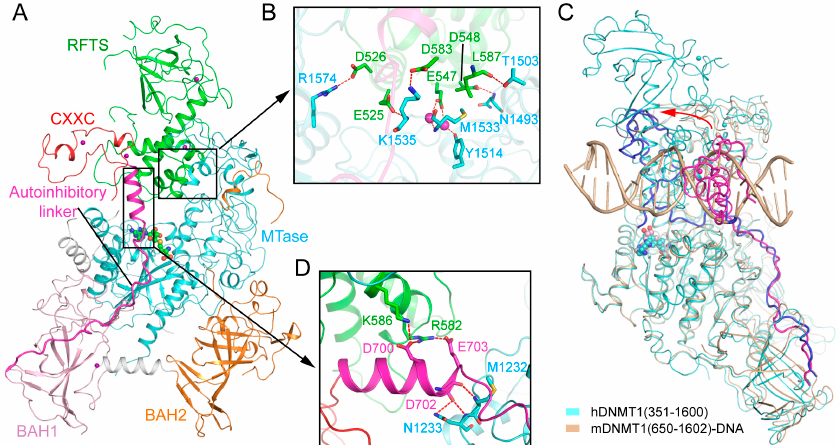
Figure 4. Structural analysis of the replication foci-targeting sequence (RFTS) domain-mediated DNMT1 autoinhibition. ( A ) Structural overview of hDNMT1 (amino acids 351–1602) (PDB 4WXX). ( B ) The intramolecular interactions between the RFTS (green) and MTase (aquamarine) domains. The hydrogen bonding interactions are depicted as dashed lines. The water molecules are shown as purple spheres. ( C ) Structural overlap between the CXXC (PDB 3PT6) and RFTS (PDB 4WXX) mediated autoinhibitory complexes, with the autoinhibitory linkers colored in blue and light magenta, respectively. The repositioning of the CXXC domain is indicated by a red arrow. ( D ) The interaction of the autoinhibitory linker (magenta) with both the RFTS (green) and MTase domains